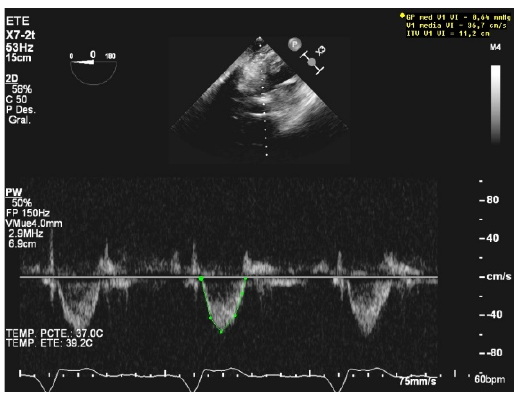
Figure 4. Pathological low left-ventricular outflow tract velocity integral (VTI).